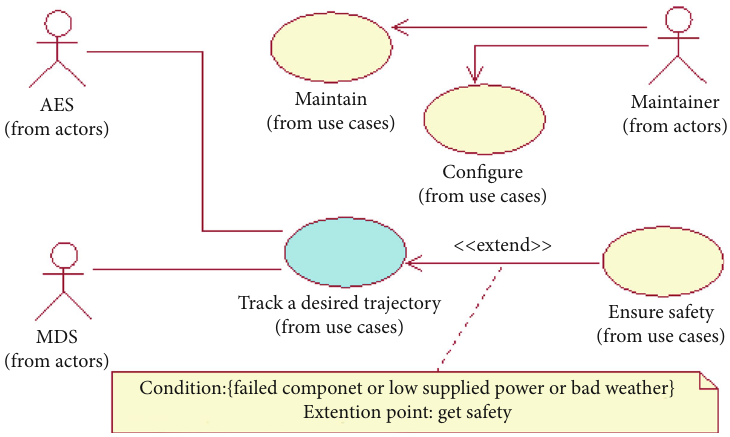
Figure 3: Use case diagram for capturing the main control requirements of the